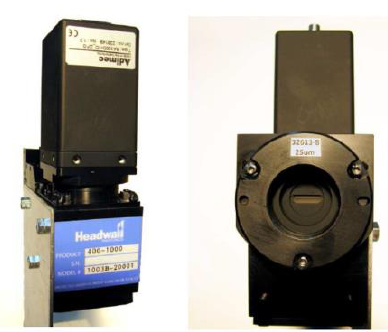
Figure 1. The push-broom hyperspectral imager- the Headwall